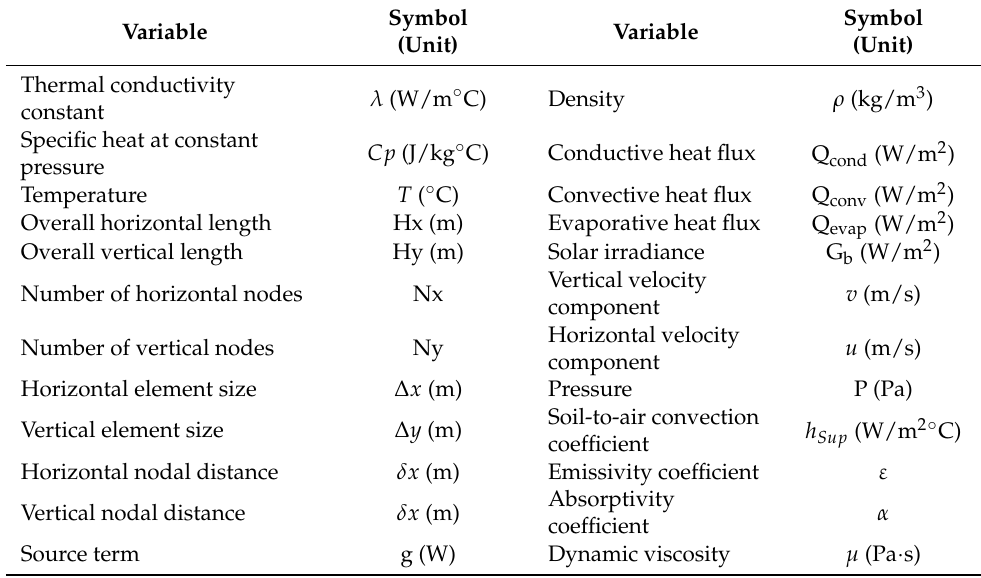
Table 1. Nomenclature and